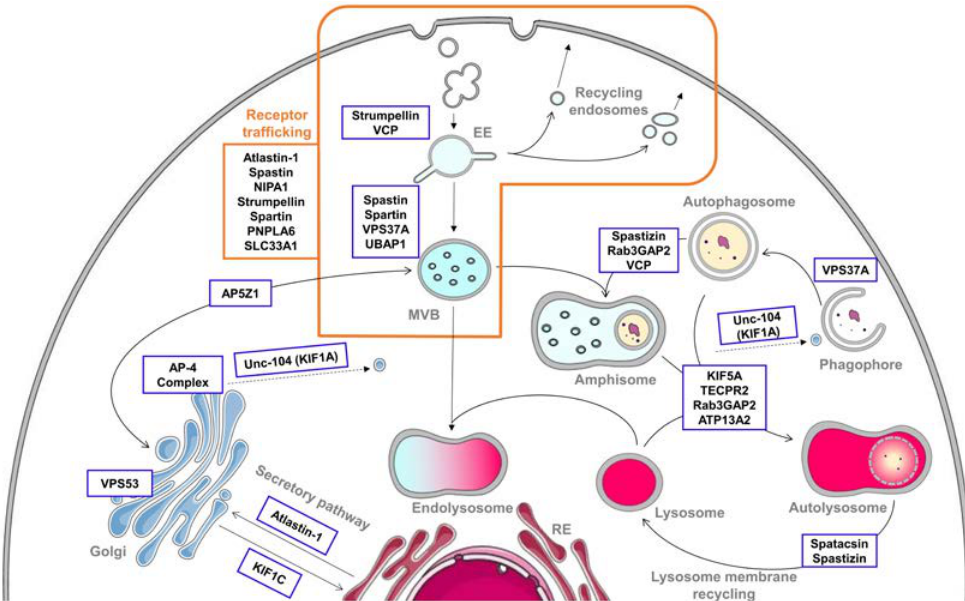
Figure 1. Implication of hereditary spastic paraplegia (HSP) proteins in endolysosomal and autophagic pathways. The endolysosomal pathway begins with endocytosis, consisting in the uptake of extracellular contents into vesicles. They fuse with early endosomes (EEs), which mature into multivesicular bodies (MVBs). During this fusion and maturation, the cargoes are sorted and can have three different fates. They can be directly recycled back to the plasma membrane via recycling endosomes, sent to the trans-Golgi network (TGN) or delivered to lysosomes for degradation. This process is notably highly involved in receptor trafficking, where numerous HSP proteins are implicated. For the degradation, the MVB has to fuse with the lysosome to form an endolysosome. However, MVBs can also fuse with autophagic compartments for their maturation, forming an amphisome. This hybrid structure will merge with a lysosome to give an autolysosome, where the degradation will take place, highlighting the importance of interconnections between endocytosis and